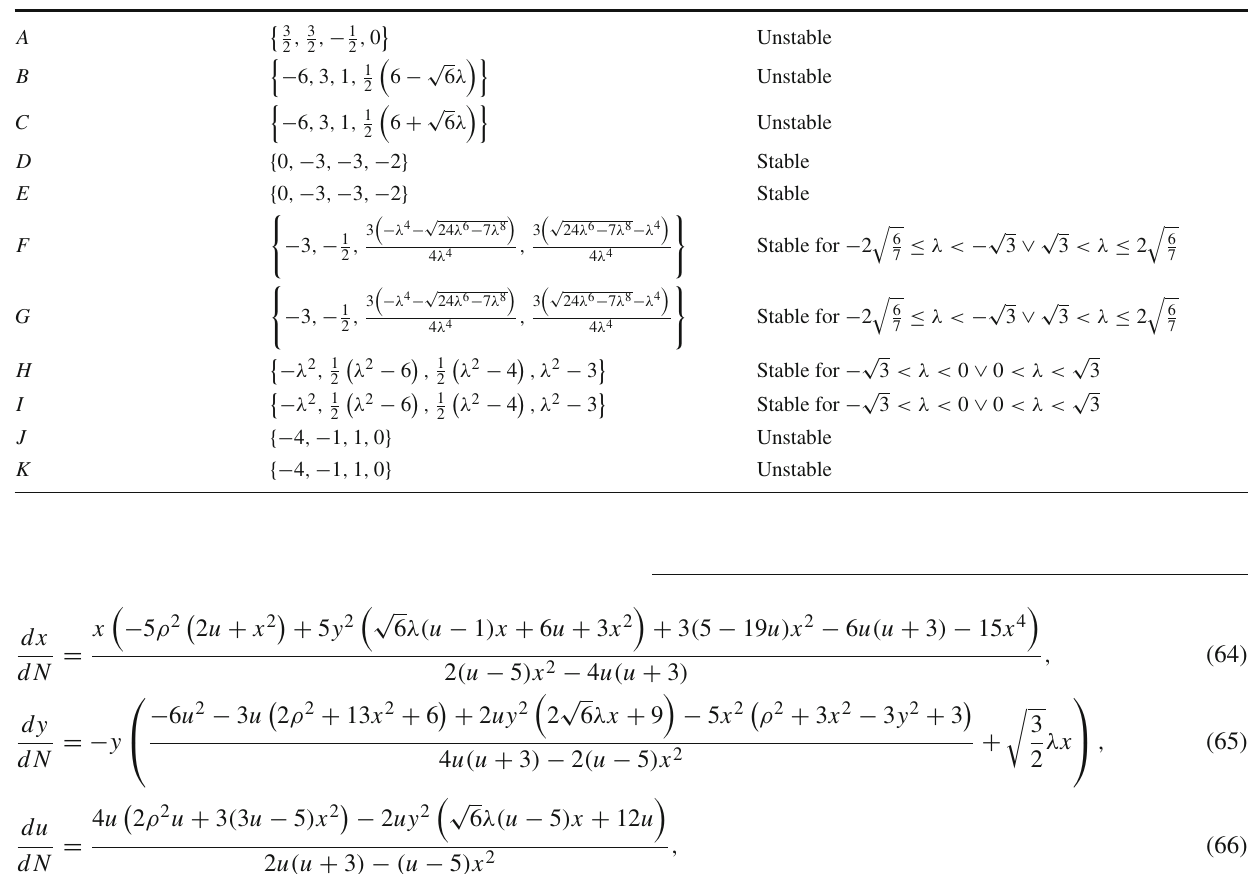
Table 4 Eigenvalues and stability of corresponding critical point Name of critical point Corresponding eigenvalues